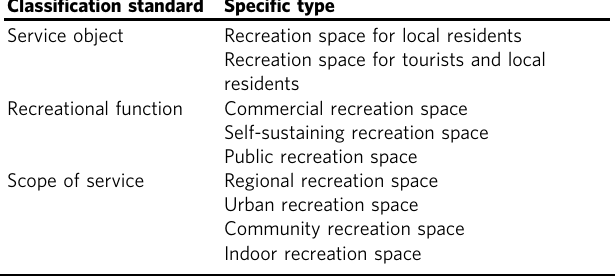
Table 1 Classi fi cation of urban recreational